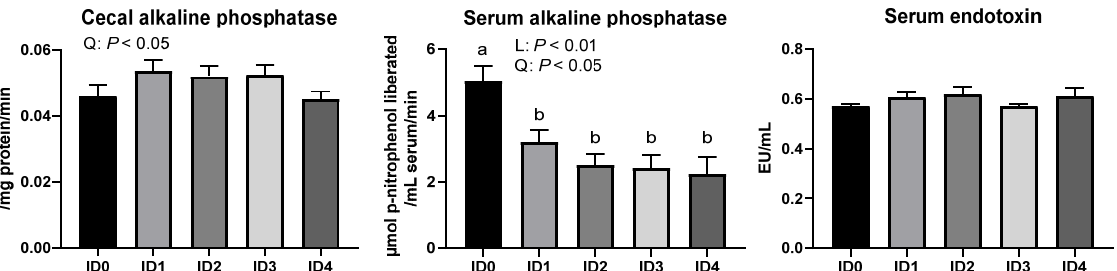
Figure 11. Effects of different infection doses of Eimeria tenella on alkaline phosphatase activities in the cecal tissue and serum and serum endotoxin concentration in broilers 6 days post-infection. Alkaline phosphatase activities in the cecal tissue and serum and serum endotoxin concentration determined in the ID0 (infection dose 0; sham-challenged with phosphate-buffered saline); ID1 (infection dose 1; challenged with 6250 sporulated oocysts of Eimeria tenella ); ID2 (infection dose 2; challenged with 12,500 sporulated oocysts of E. tenella ); ID3 (infection dose 3; challenged with 25,000 sporulated oocysts of E. tenella ); ID4 (infection dose 4; challenged with 50,000 sporulated oocysts of E. tenella ) groups. Data were analyzed by using One-way ANOVA followed by the Tukey’s multiple comparison test and means with different letters (a and b) differ significantly ( p <